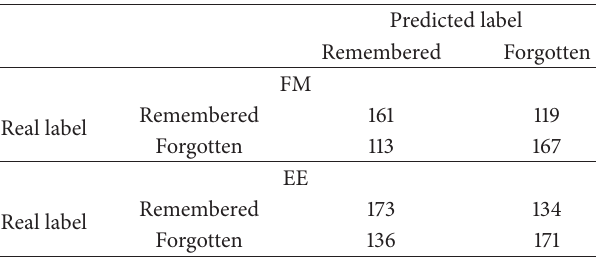
Table 1: Confusion matrices for FM and EE.